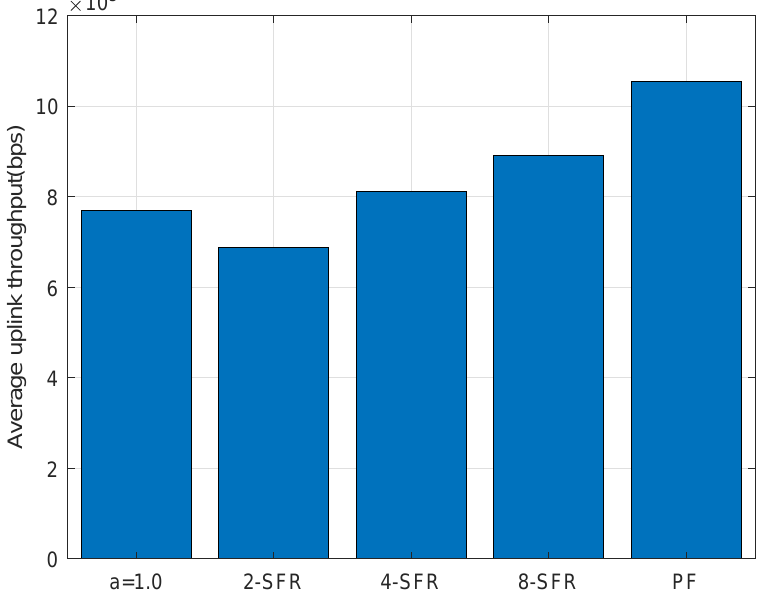
Figure 12. Average throughput of TAU of PF-based power control and